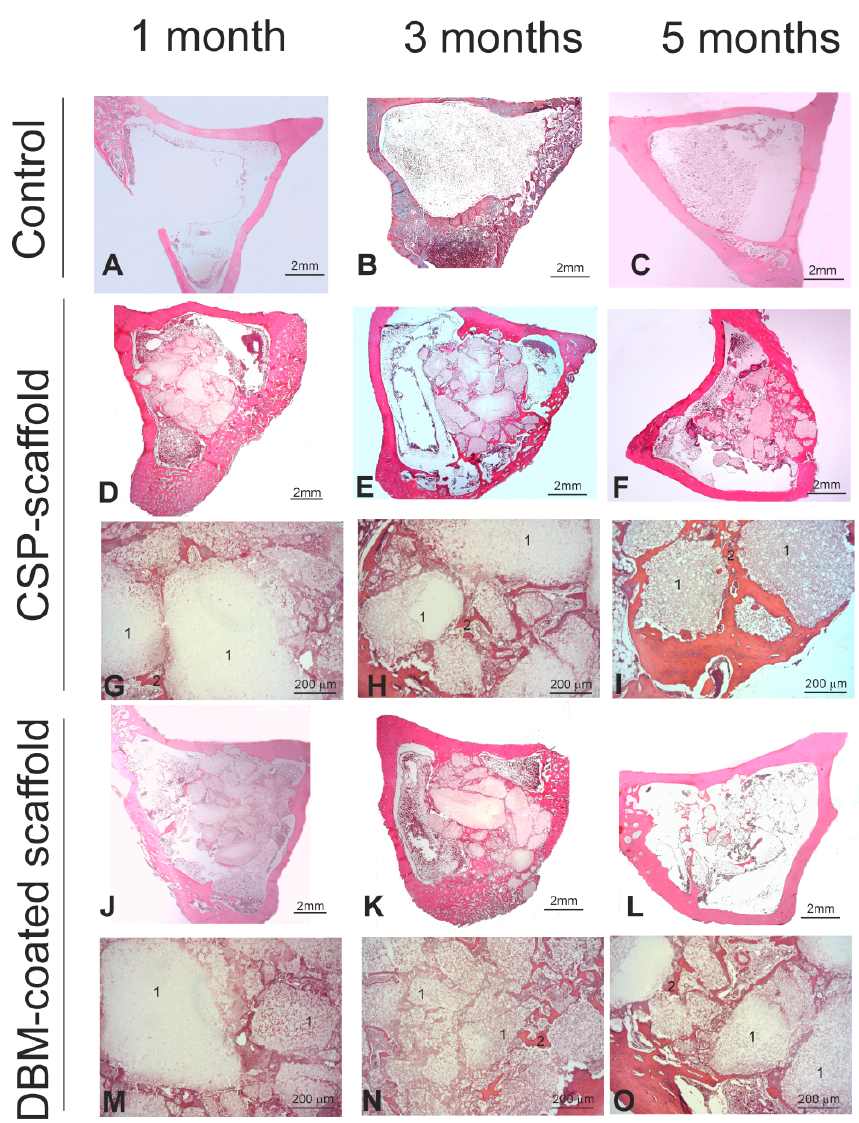
Figure 7. ( A – C ) Representative images of the tibia samples from the control, ( D – I ) implanted CSP and ( J – O ) DBM-coated scaffolds. In the controls, the bone defect ( A ) was repaired by physiological bone repair at months 3 and 5 ( B , C , respectively). In the CSP group, the scaffold surface progressively decreased ( D – I , number 1) with increasing neoformed bone organization ( G – I , number 2). Similarly, the DBM-coated scaffold surface progressively decreased from month 1 to month 5 ( J , K , M – O , number 1) but, in this case, the neoformed bone organization slightly diminished ( M , N , number 2) compared with the CSP scaffold. Hematoxylin and eosin stain. (1, residual scaffold; 2, neoformed bone).